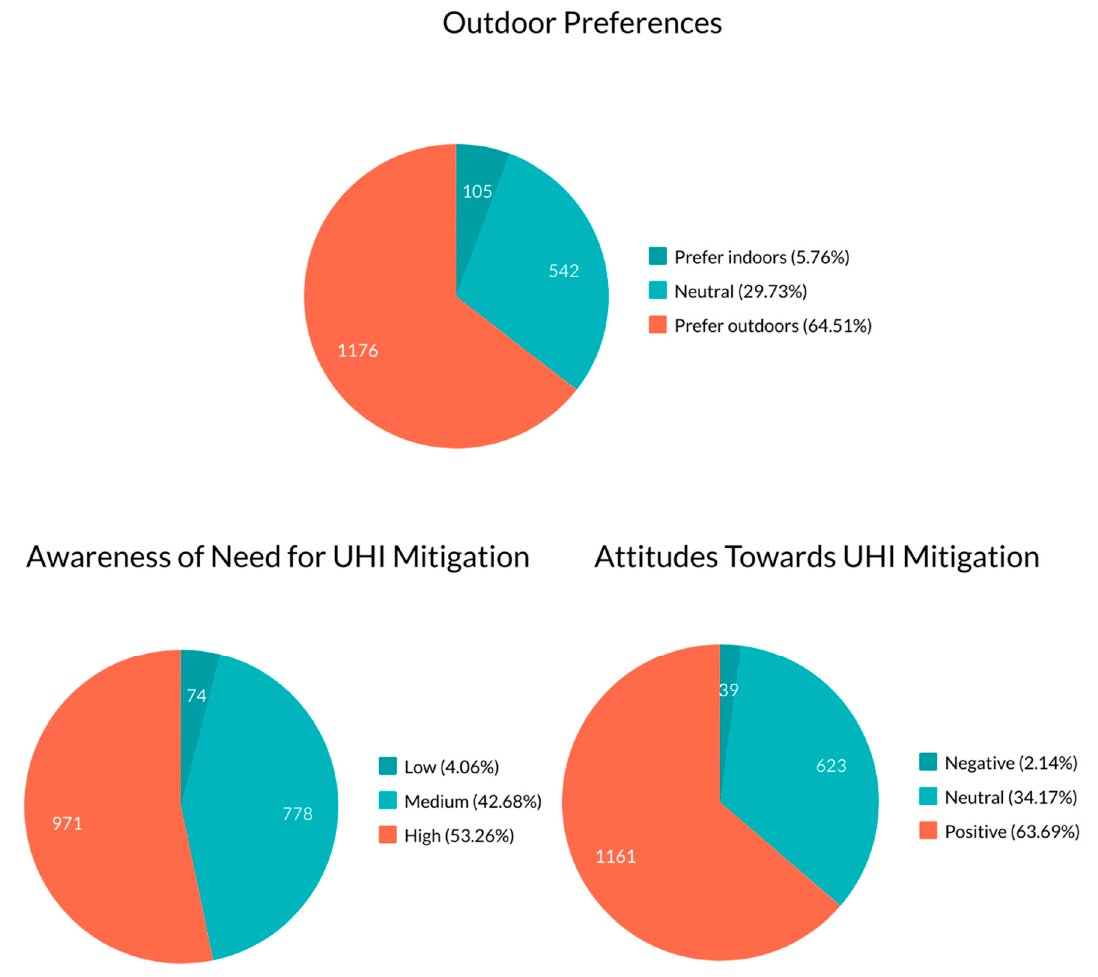
Figure 4. Descriptive statistics from our sample on the level of awareness of the need for UHI mitigation measures, on attitudes towards UHI mitigation as well as on outdoor preferences.